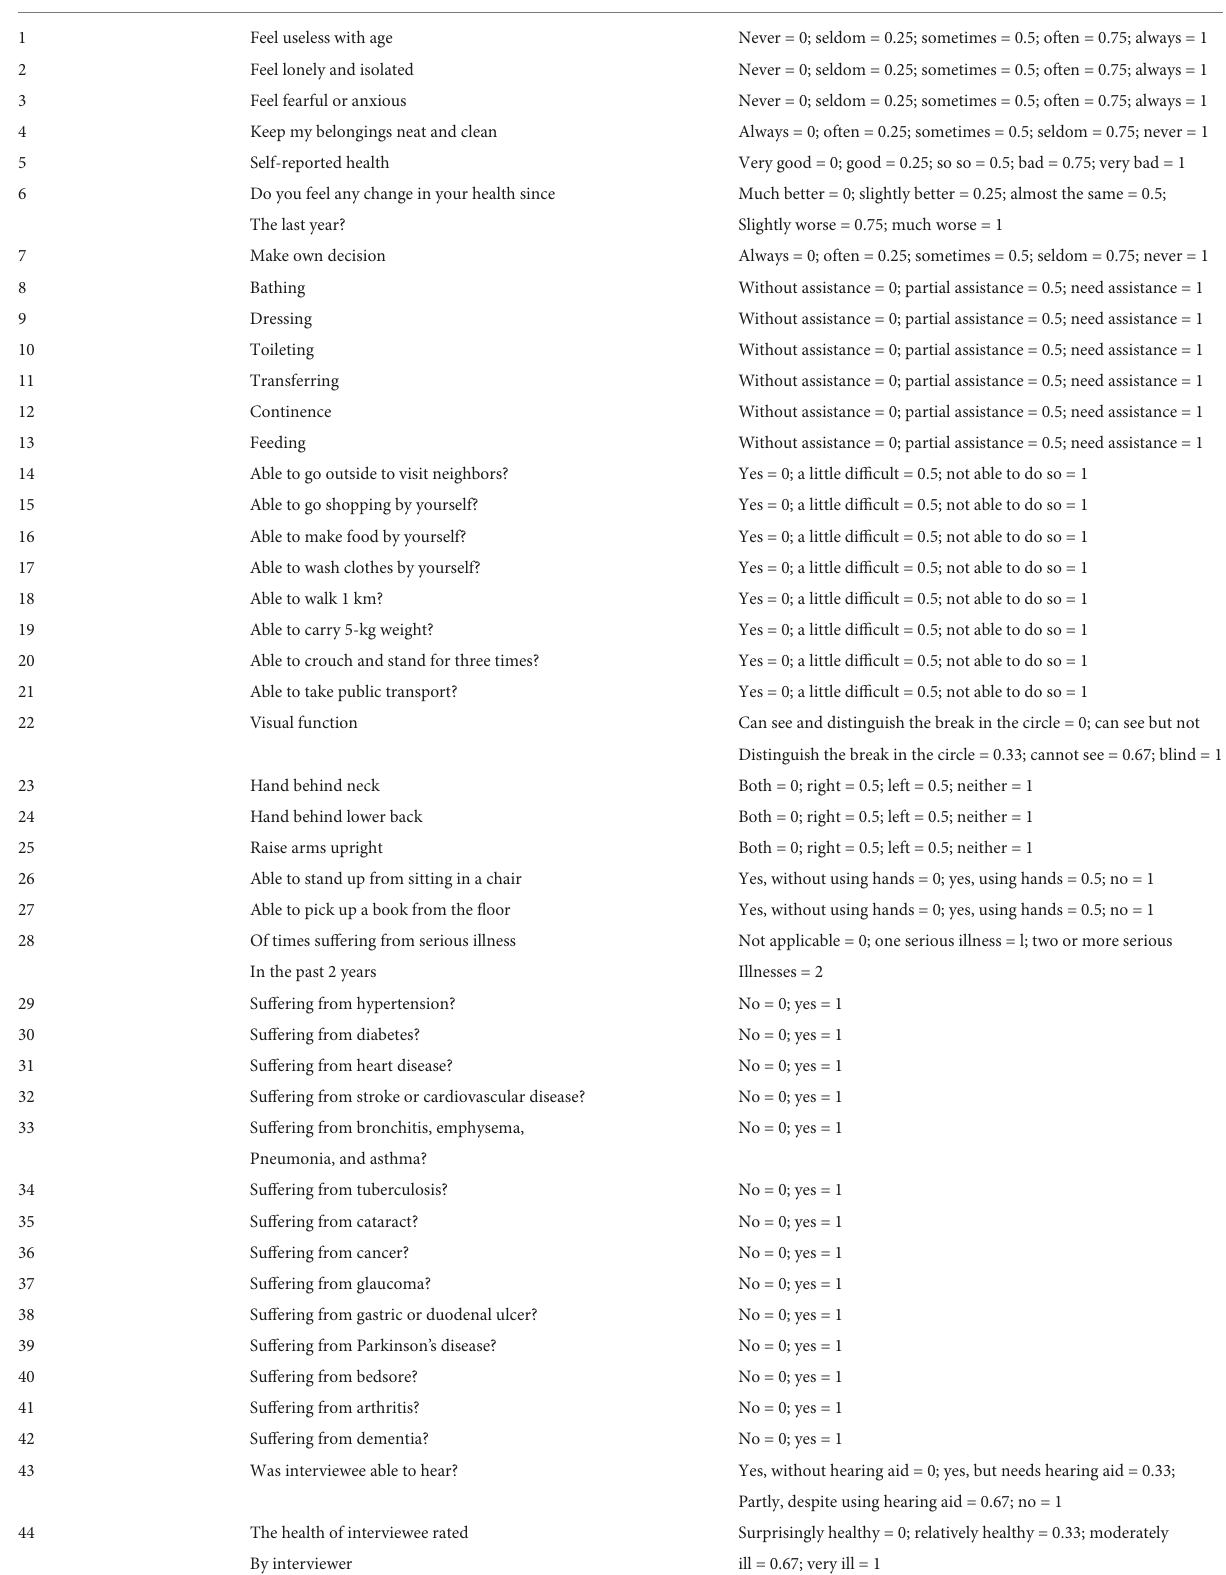
TABLE 1 Variables for constructing frailty index in the 2018 waves of Chinese Longitudinal Healthy Longevity